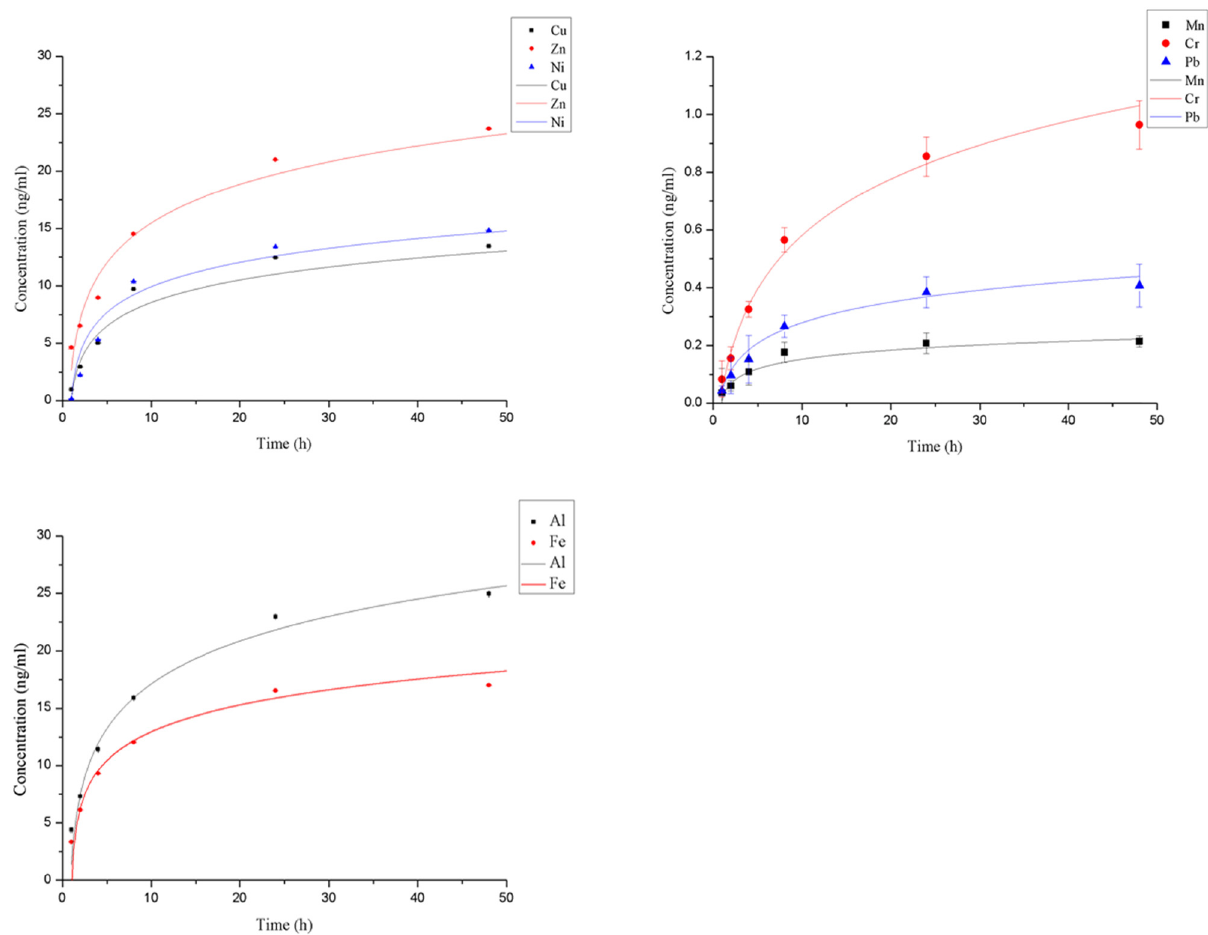
Figure 1: E ff ect of time on the concentration of each element in migration.